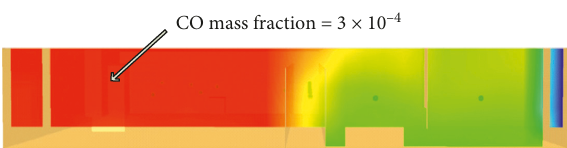
Figure 9: Slice of the CO mass fraction at